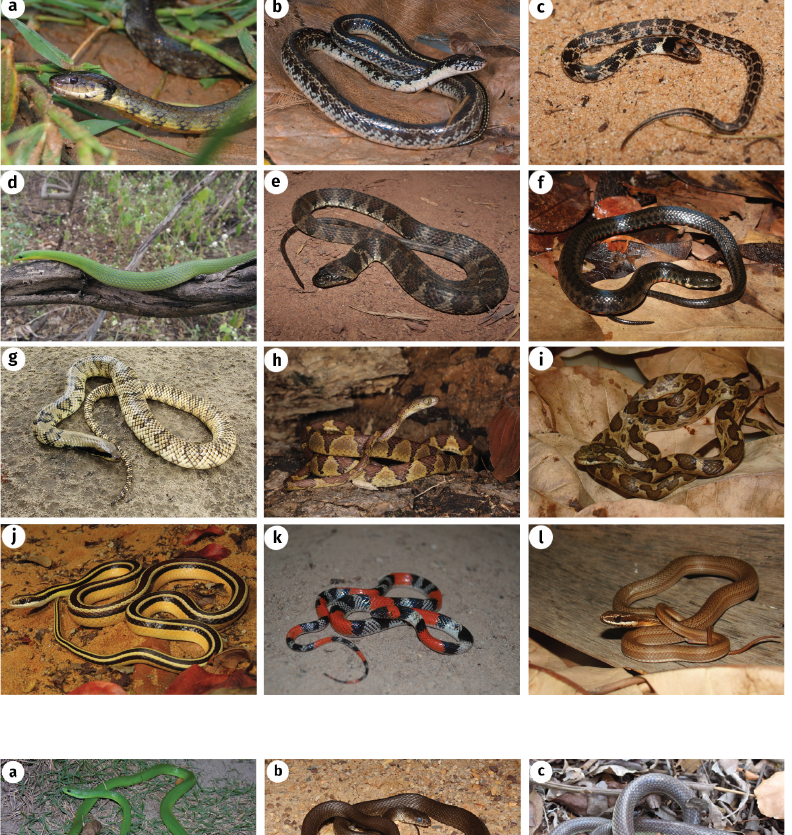
Figure 5. Snakes from Rio Grande do Norte state, Brazil. Dipsadidae: ( a ) Philodryas olfersii , ( b ) P . patagoniensis , ( c ) Phimophis guerini , ( d ) Pseudoboa nigra , ( e ) Psomophis joberti , ( f ) Sibon nebulatus , ( g ) Taeniophallus occipitalis , ( h ) Thamnodynastes almae , ( i ) T . phoenix , ( j ) T . sertanejo , and ( k ) Xenodon merremii . Photos c and e by G.A. Pereira-Filho.